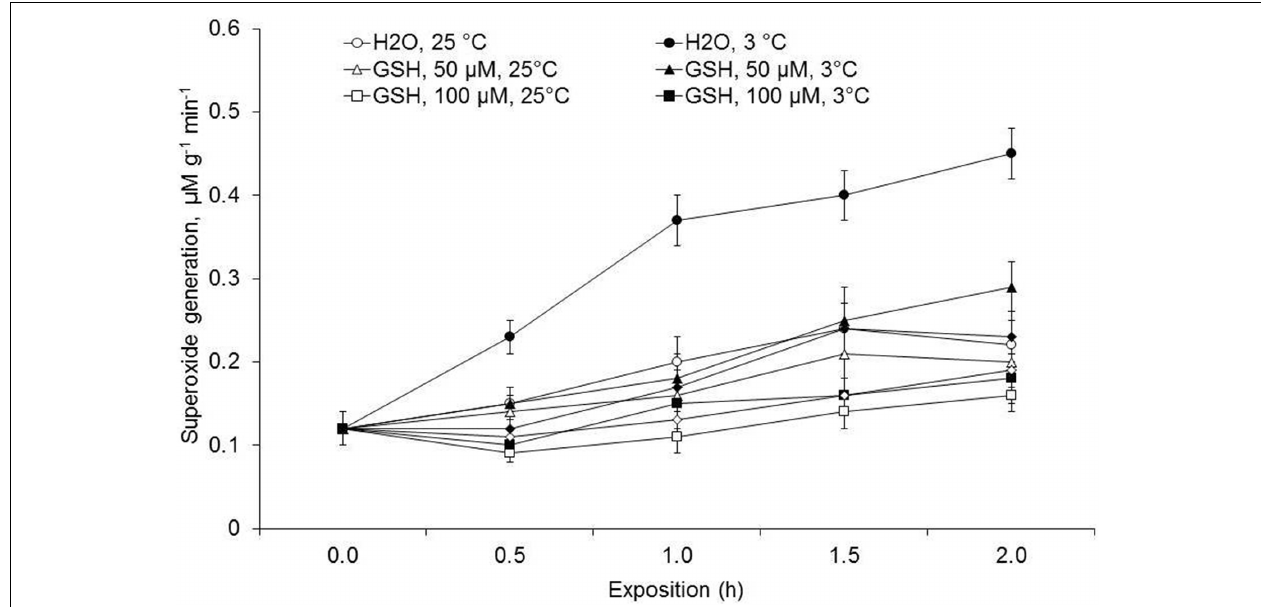
FIGURE 1 | Effects of glutathione (GSH) concentrations on rate of O 2 • − generation in the leaf discs of Cucumis sativus at 3 and 25 ◦ C temperatures.